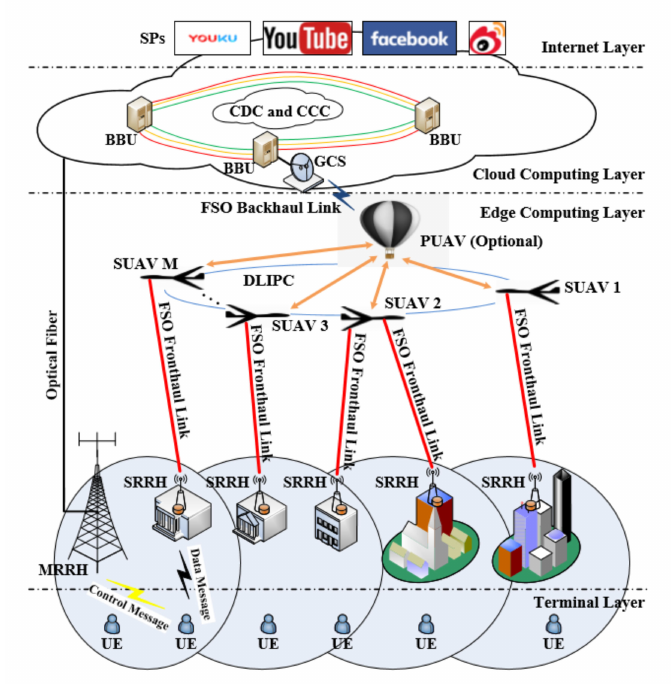
Figure 10. Illustration of the UAV 5G and beyond 5G wireless optical network architecture